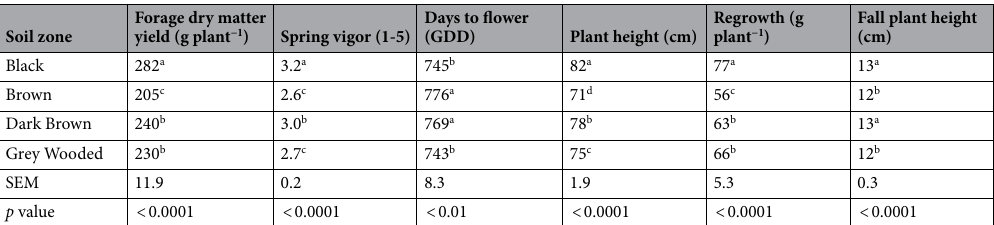
Table 2. Mean comparison of six agro-morphological traits of 14 alfalfa populations with long-term grazing history among four soil zones from 2018 to 2020 grown at the Agriculture and Agri-Food Canada Saskatoon Research Farm, SK, Canada. Note: The different lowercase letters within a column are significantly different according to Tukey’s HSD at p ≤ 0.05. SEM, standard error of the mean.